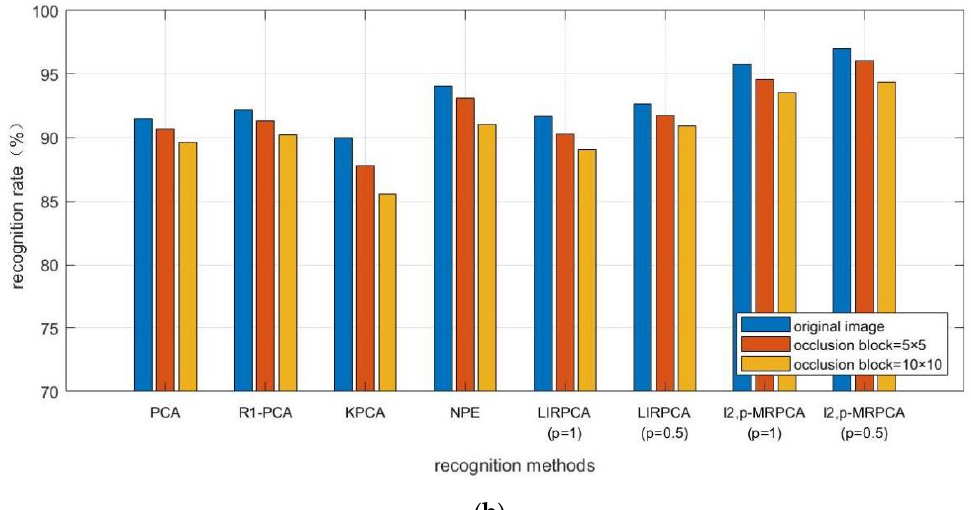
Figure 3. Recognition rate of PCA, 𝑅 1 -PCA, KPCA, NPE, LIRPCA ( 𝑝 = 0.5 ), LIRPCA ( 𝑝 = 1 ), 𝑙 2,𝑝 -MRPCA ( 𝑝 = 0.5 ), 𝑙 2,𝑝 -MRPCA ( 𝑝 = 1 ) on YALE database ( a ) Number of training samples n = 4 ( b ) Number of training samples n = 5.